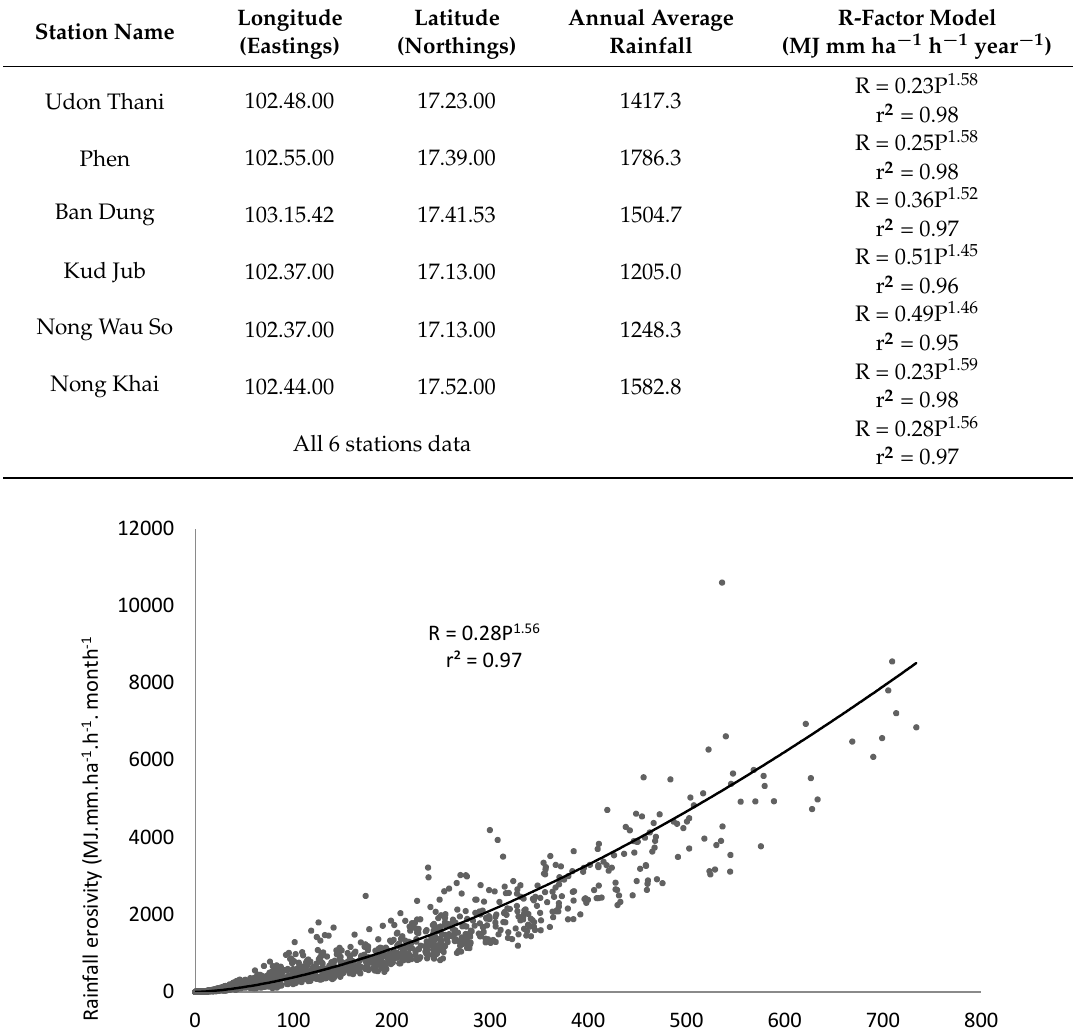
Figure 4. The relation between rainfall erosivity and monthly rainfall.